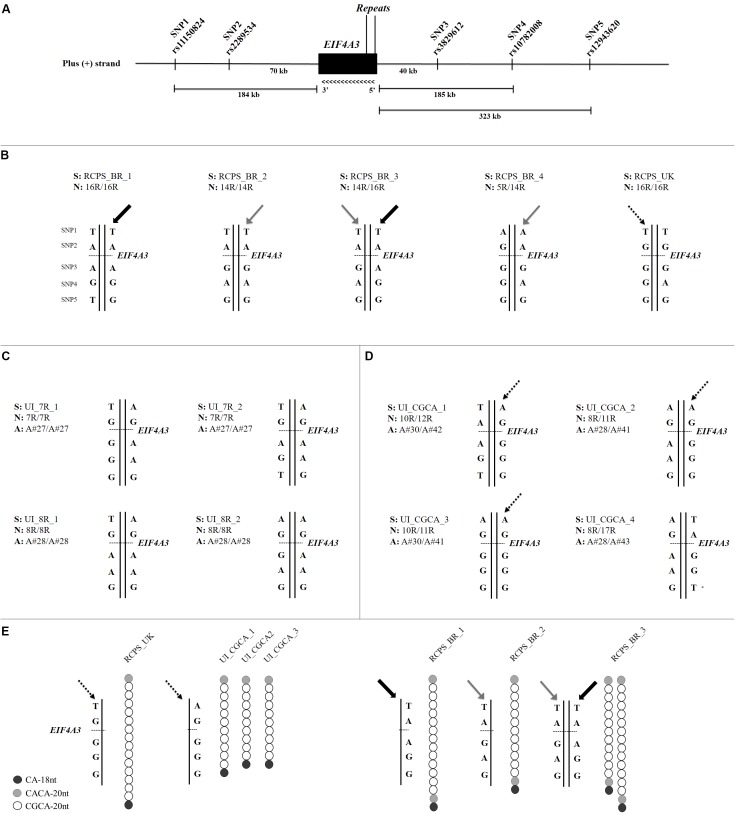
(A) Schematic representation of the SNPs and microsatellite markers flanking EIF4A3 (11,970 bp). We used five SNPs for haplotype characterization and numbered them as following: SNP1 (rs11150824), SNP2 (rs2289534), SNP3 (rs3829612), SNP4 (rs10782008), and SNP5 (rs12943620), according to their relative genomic position on the annotated plus strand (GRCh38/hg38). (B) Haplotype analysis of five RCPS patients, four Brazilians, and one from the United Kingdom. Gray arrows indicate the haplotype associated with the 14-repeat alleles and black arrows indicate the haplotype associated with the 16-repeat alleles in Brazilian RCPS. UK RCPS presented a similar haplotype observed in the unaffected individuals with the disease CGCA-20nt motif (dotted arrow). (C) Haplotype analysis of four unaffected individuals without the disease CGCA-20nt motif. These individuals are homozygous for seven or eight repeats. (D) Haplotype analysis of four unaffected individuals with the disease CGCA-20nt motif. Dotted arrows indicate the haplotype present in three of these individuals. (E) Comparison between haplotypes of the UK RCPS patient, the three unaffected individuals with the CGCA-20nt motif and the three Brazilian RCPS patients. S is the sample ID, N is the total number of repeats for each allele and A is the allele structure (Figure 1 and Supplementary Table S2). Each bar represents an allele.